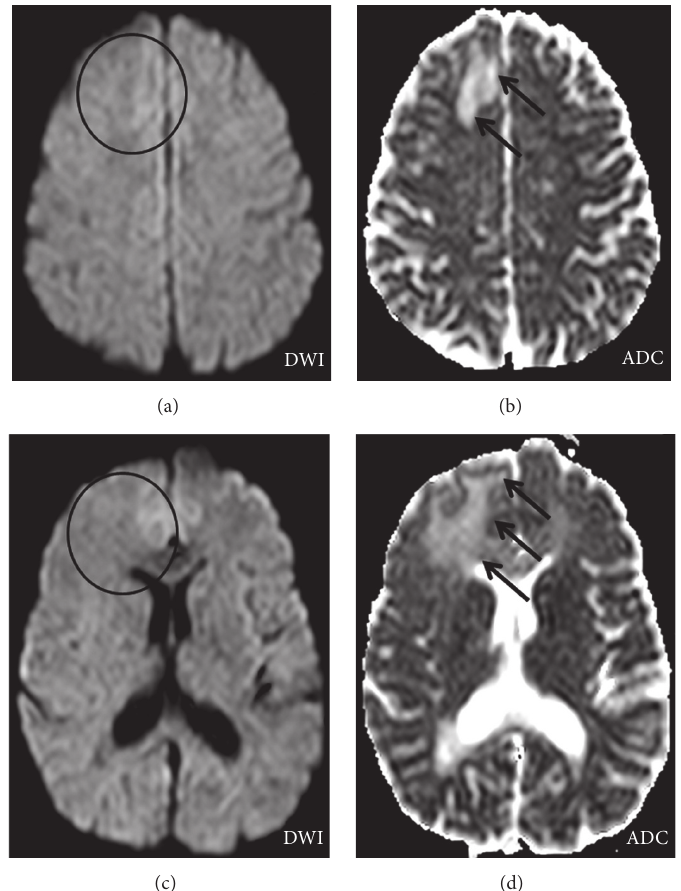
Figure 3: No signs of abnormal diffusion. Diffusion weighted MRI at 1.5 T ((a) and (c)) did reveal neither signs of central hyperdiffusibility (circles) nor signs of restricted diffusion (circles) at the edge of PML lesions (black arrows, (b) and (d)). Both of which were reported to be characteristic for PML